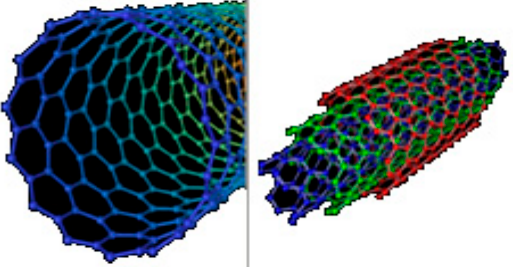
Figure 1. SWCNT and MWCNTs.